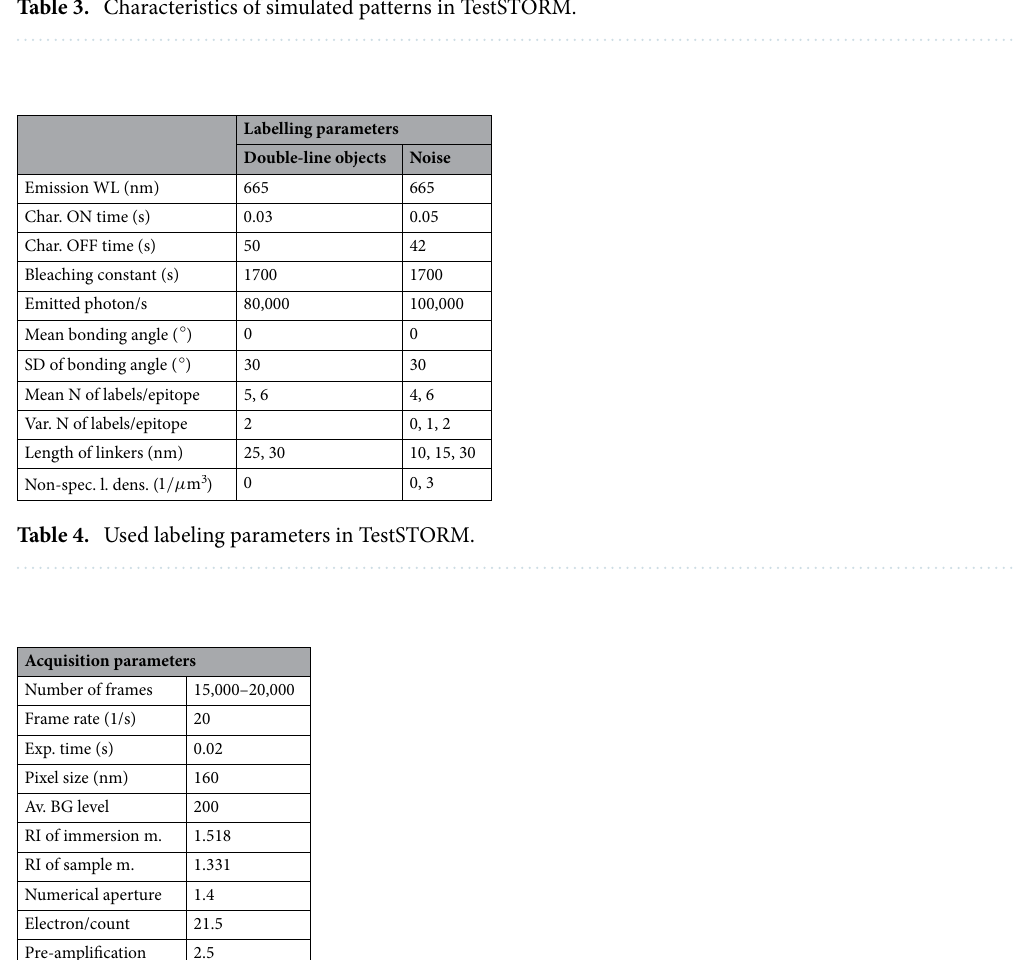
Table 3. Characteristics of simulated patterns in TestSTORM.